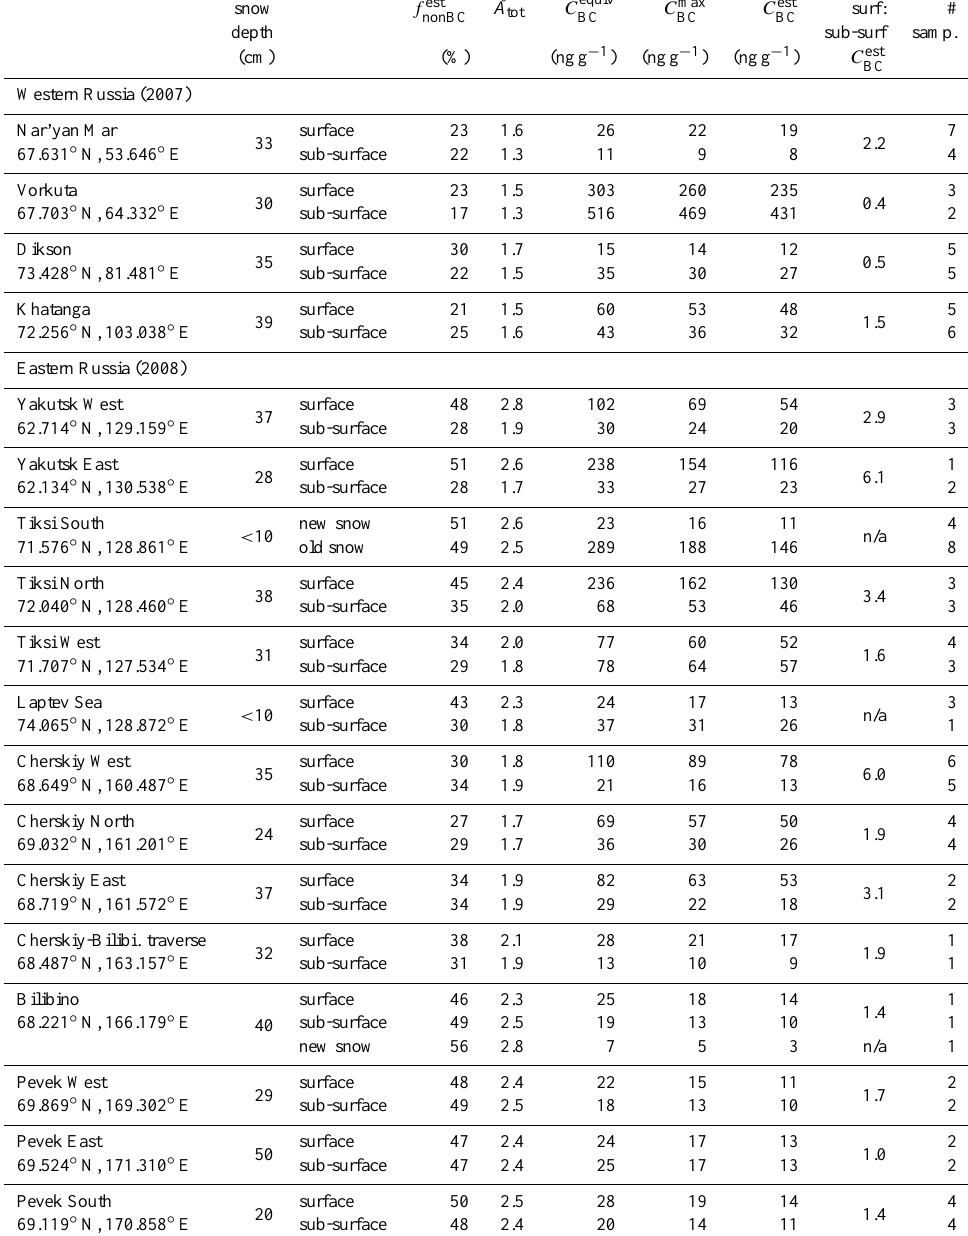
Table 7. Average values for surface and sub-surface snow in Russia. In locations where two adjacent samples (sample pairs) were taken the average of the two pairs is considered a single sample. For the Tiski South site the snow was thin so there are no sub-surface samples. Therefore for that site we show averages for new snow and old snow. The “new snow” at Tiksi was drifting in from the north. The “new snow” at Bilibino had just fallen during the previous few hours in calm